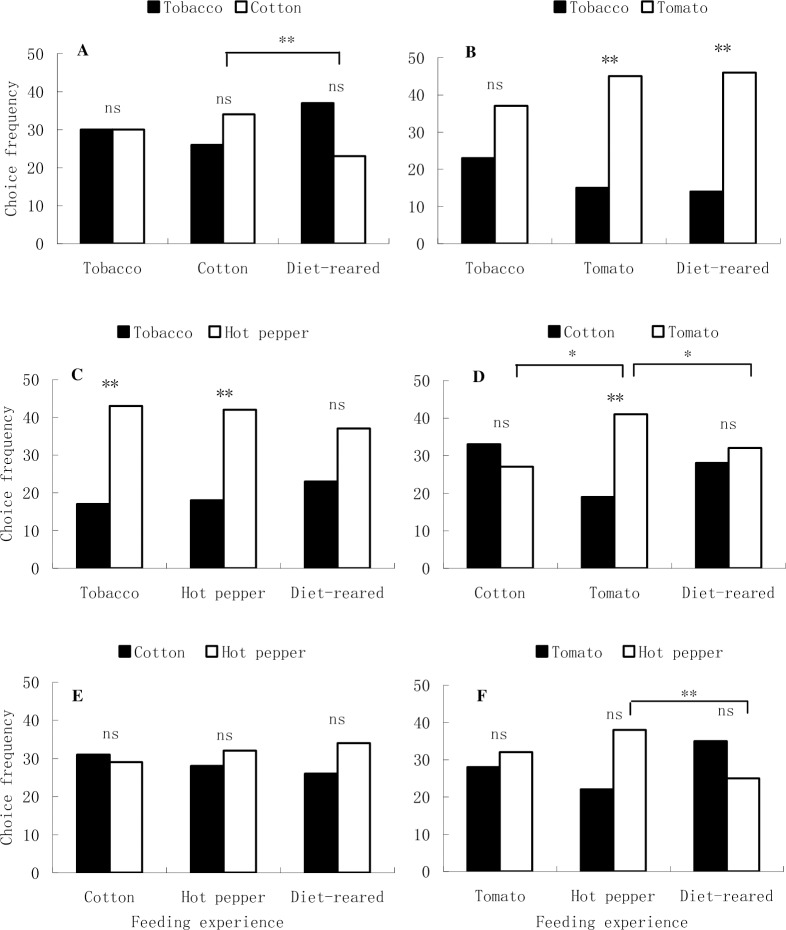
Choice frequencies of H. armigera larvae with different feeding experiences in six subsets of host leaf pairs.“**” attached to the bar pairs indicates significant within-group difference at P = 0.01 level, and “ns” indicates no significant within-group difference, analyzed by chi-square test with Yate-correction. “*” and “**” attached to the lines spanned over two bar pairs indicate significant between-group difference at P = 0.05 and P = 0.01 levels, respectively, analyzed by chi-square test (to simplify the figure, between-group differences with no significance are not shown).